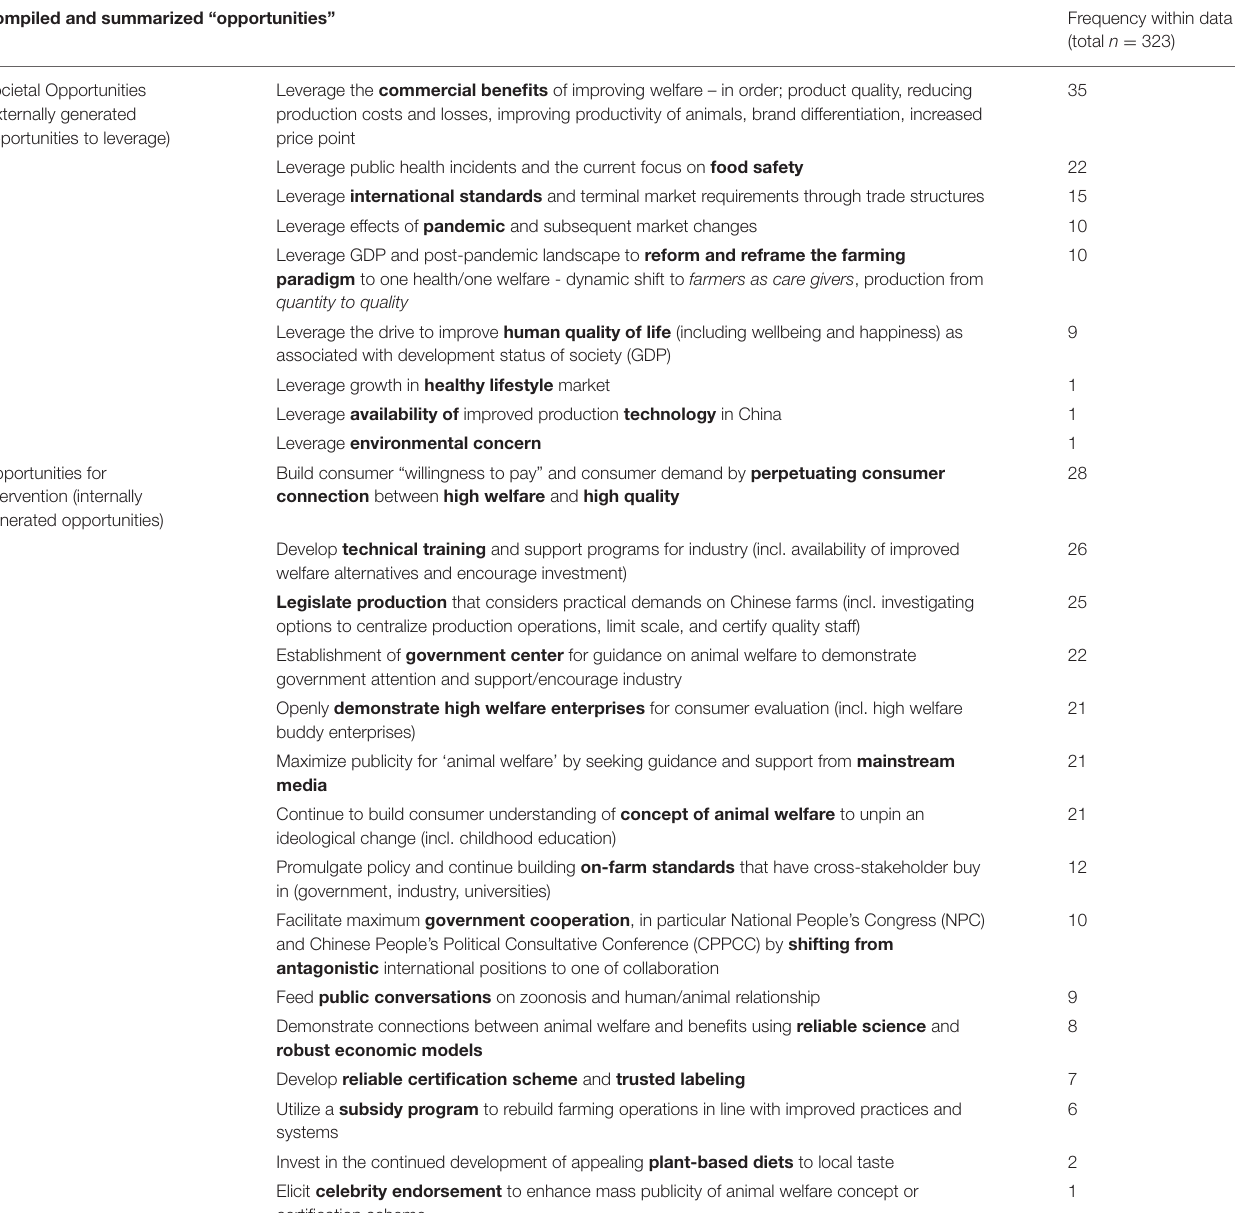
TABLE 5 | Summary of “opportunities” ( n = 323) based on participants’ responses and the frequency with which each opportunity appeared in the data. Compiled and summarized